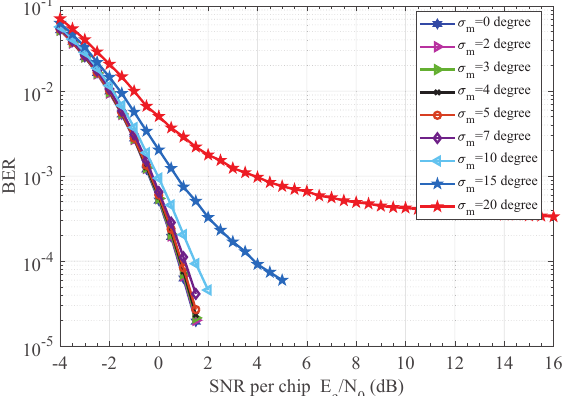
Figure 12. BER performance of proposed receiver versus dynamic CPO. CPO: carrier phase offset.